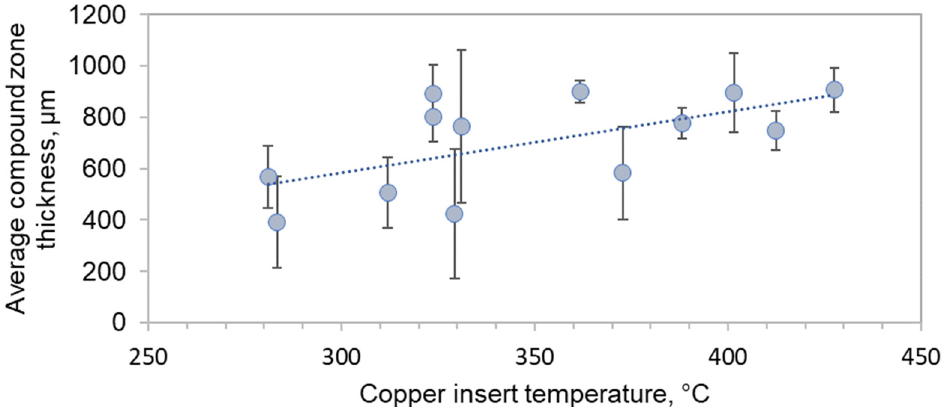
Figure 7. Average of the compound zone thickness depending on the copper insert temperature during casting.